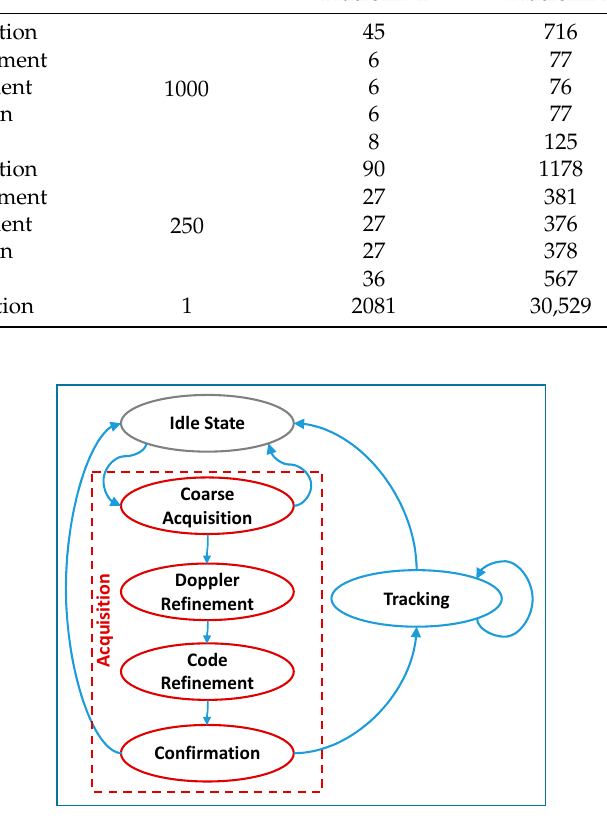
Figure 6. Simplified block diagram of the channel finite state machine of the NGene family receivers, adapted and restyled from [17].